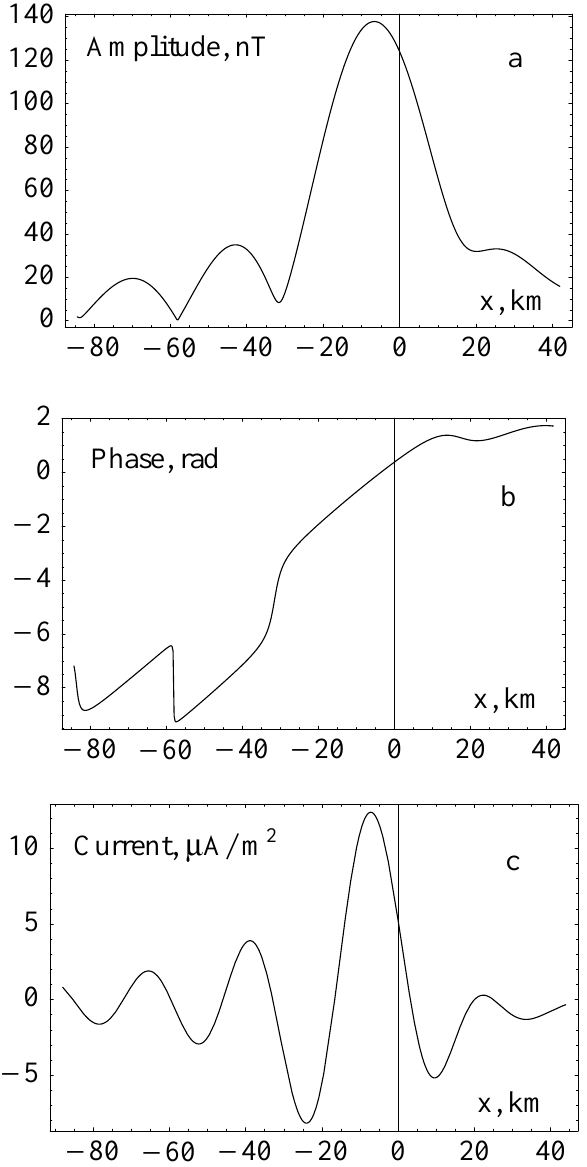
Fig. 12. Snapshort of the transverse profiles of the magnetic field amplitude (a) , phase (b) , and the parallel electric current from the dispersive FLR model at the end of magnetic field line. The FLR position corresponds to x = 0, poleward is to the left.